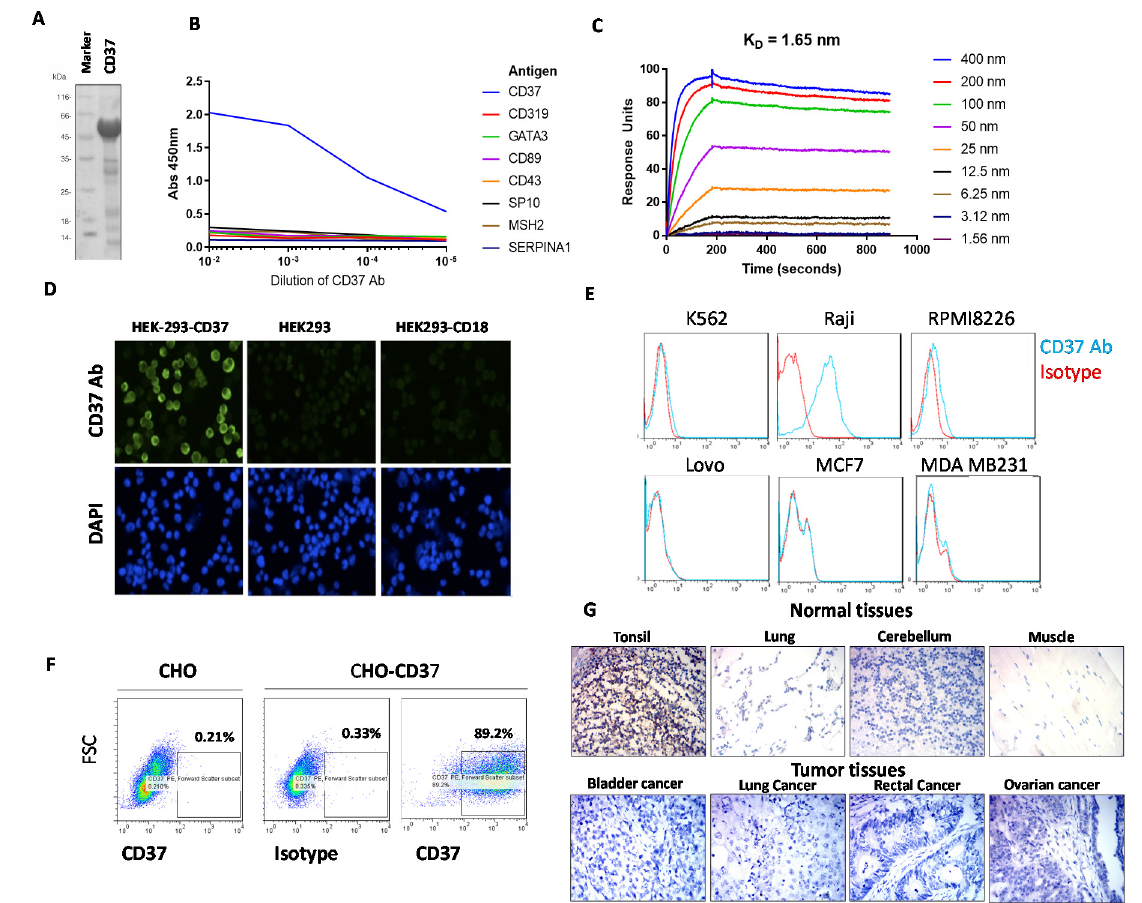
Figure 1. ( A ). Recombinant CD37 extracellular domain protein used for enzyme-linked immunosorbent assay, ELISA assay. The CD37 protein had C-terminal Maltose Binding Protein, MBP and His tag. SDS (sodium dodecyl sulfate) gel shows 56 kDa CD37 protein. ( B ). ELISA shows binding of CD37 antibody 2B8D12F2D4 (2B8) clone to CD37 protein and no binding to other unrelated control proteins. ( C ). Surface plasmon resonance kinetic data collected on Biacore with anti-CD37 2B8 antibody bound to mouse capture chip and titration of CD37-His. KD of 1.65 nm was measured from two independent experiments. ( D ). Immunostaining shows binding of CD37 2B8 clone antibody to CD37 antigen in HEK293-CD37 cells but not in HEK293-CD18 and HEK293 cells. Indirect immunofluorescence microscopy was performed with anti-CD37 2B8 followed by Goat-Anti-mouse IgG Alexa 488 (top row) and counterstained with DAPI (4 (cid:48) ,6-diamidino-2-phenylindole) nuclear stain (bottom row). ( E ). FACS shows positive staining of CD37 2B8 antibody in CD37-positive Raji cells but not in other cancer cell lines. ( F ). FACS with CD37 antibody shows specific detection of cell surface CD37 in CHO-CD37 cells but not in CHO cells. ( G ). Indirect immunohistochemistry was performed on health (upper panel) and tumor (lower panel) adult tissue sections with anti-CD37 2B8 staining, followed by anti-mouse HRP (horseradish peroxidase). Positive staining was observed in tonsil, a lymphoid tissue, but not in normal lung, cerebellum, or muscle. Negative staining was observed in representative tumor